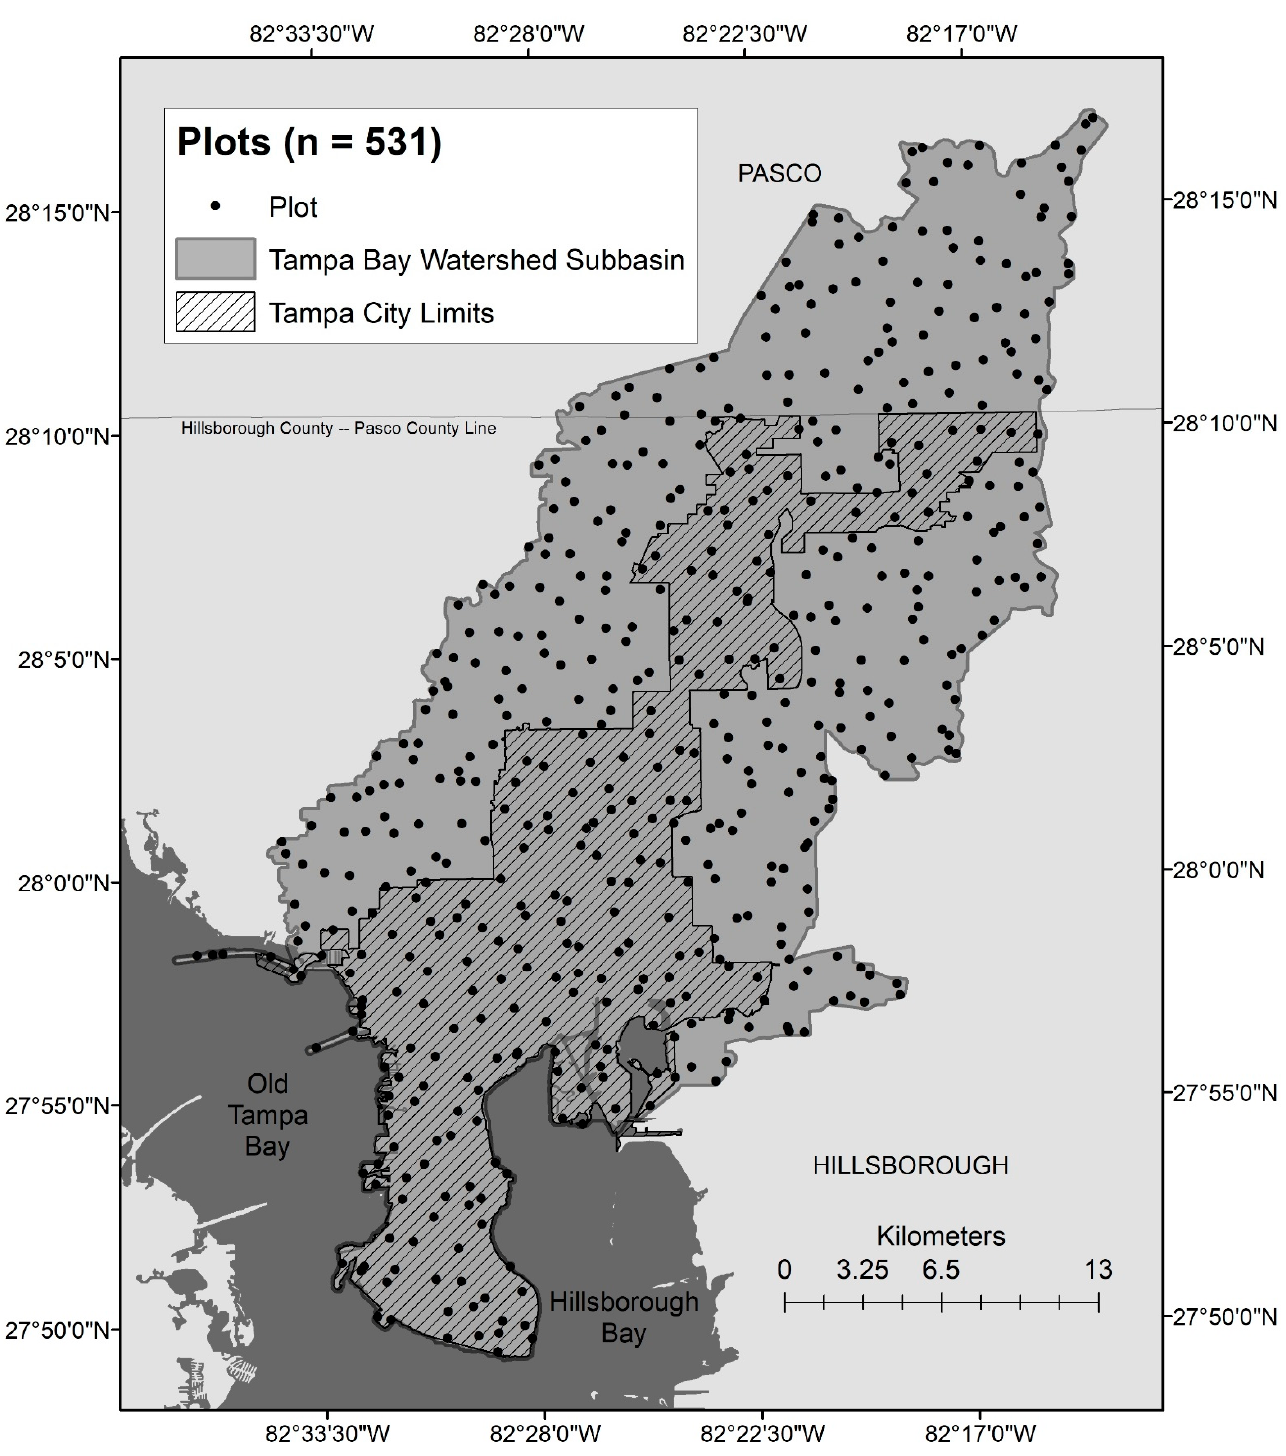
Figure 2. The study area subbasin located inside the greater Tampa Bay Watershed showing sample plot locations within and around the City of Tampa, Florida.